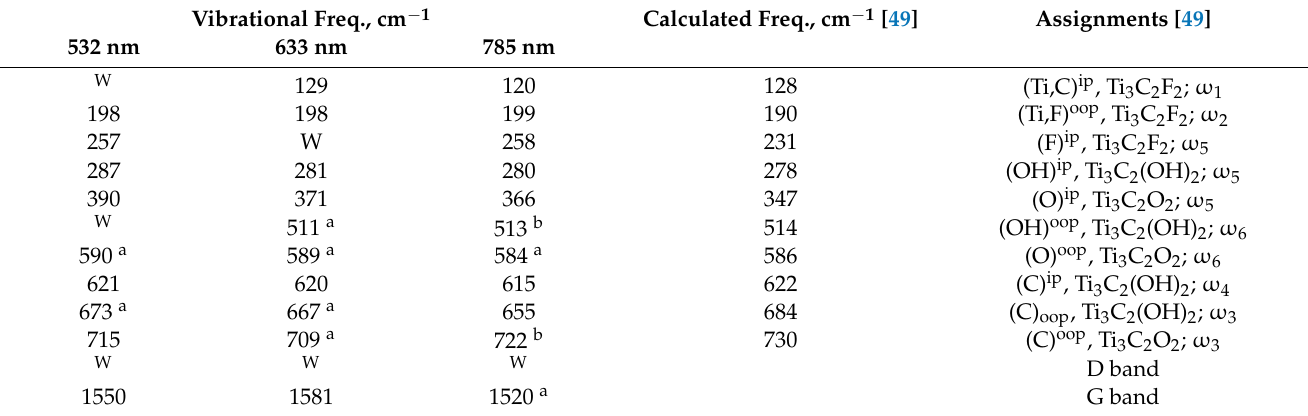
Table 2. Vibrational frequencies of Ti 3 C 2 T x -based MXene